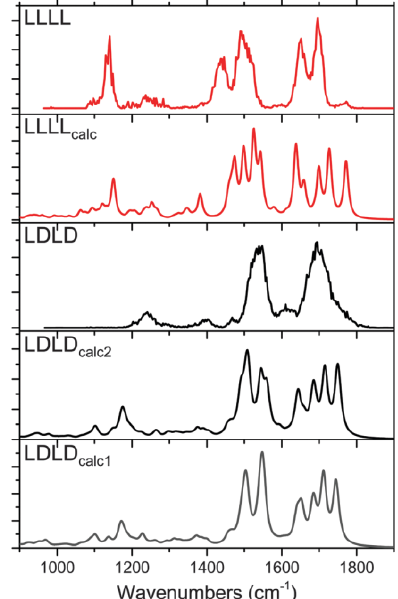
Figure 11. Experimental spectra of protonated LLLL and LDLD together with some simulated spectra (LLLL calc , LDLD calc1 and LDLD calc2 ) [61]. Reprinted with permission from RSC.